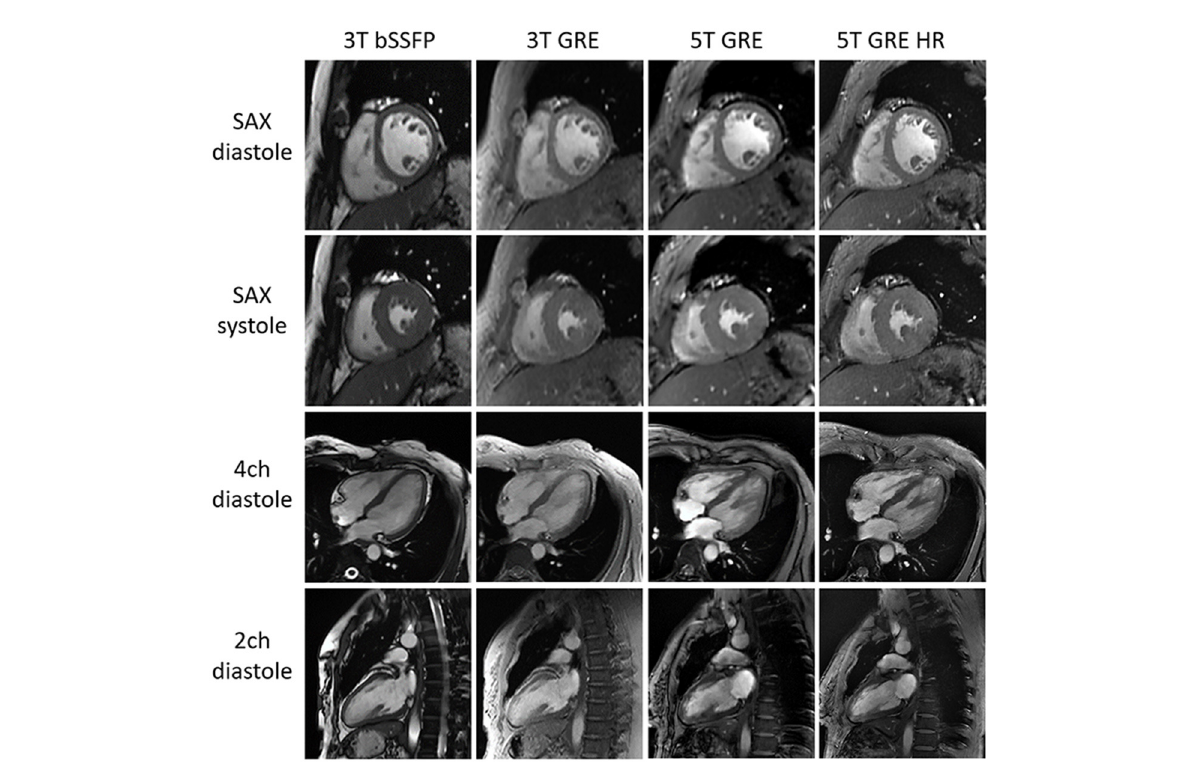
FIGURE2 Typical CMR cine images of one subject. All images are free of major artifacts and show good image quality.